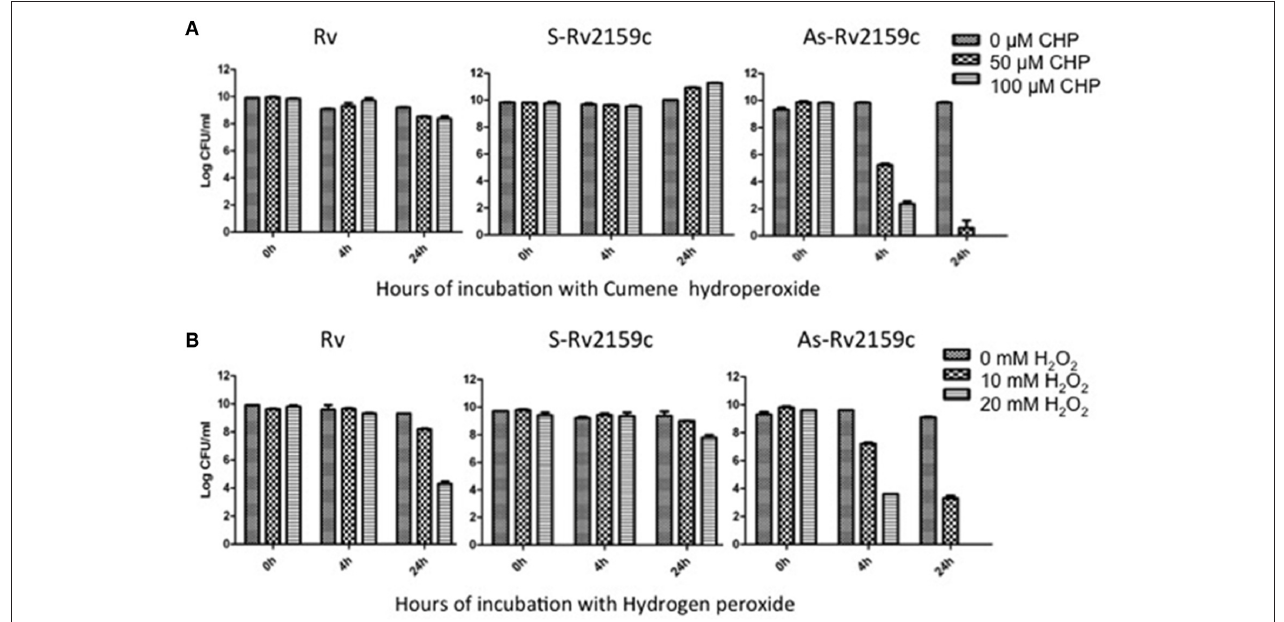
FIGURE 6 | Effect of peroxides on S-Rv2159c and As-Rv2159c. (A) The Rv, S-Rv2159c and As-Rv2159c constructs in M. tuberculosis were diluted to an OD 600 of 0.1 in complete 7H9 medium and CFU was measured at 0, 4, and 24h post exposure with (A) 0, 50 and 100 µ M of CHP and (B) 0, 10 and 20 mM hydrogen